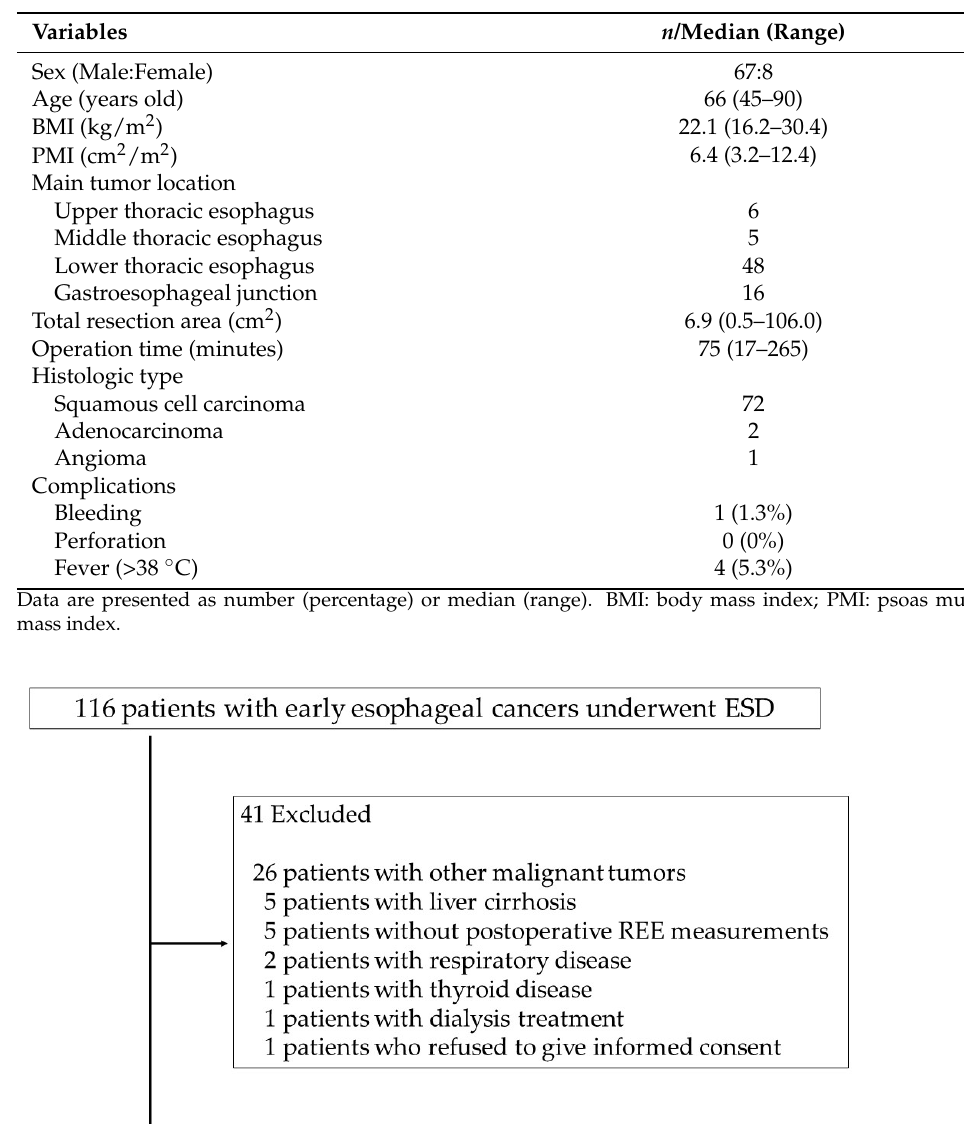
Table 1. Patient baseline characteristics.